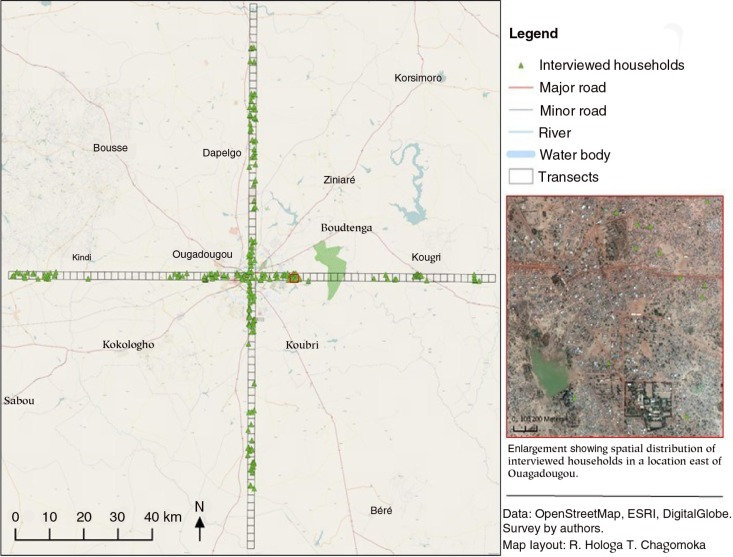
Transect approach.